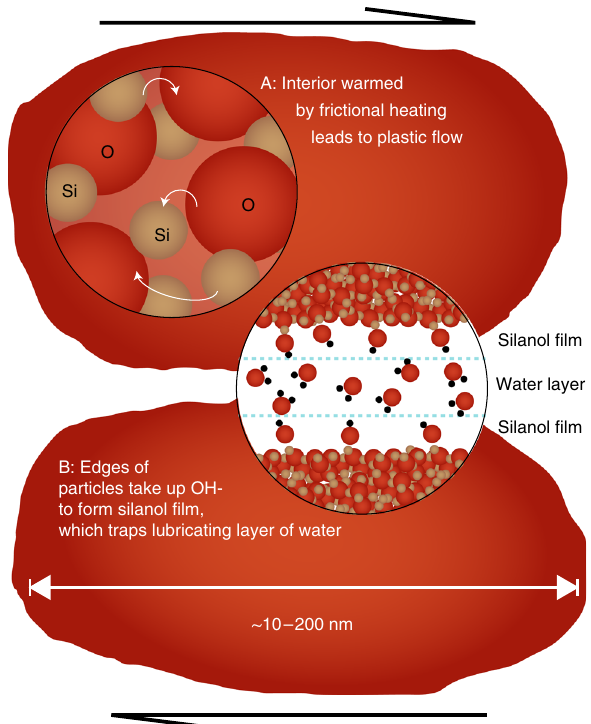
Fig. 7 Schematic cartoon showing parallel operation of two slip weakening mechanisms. See text for